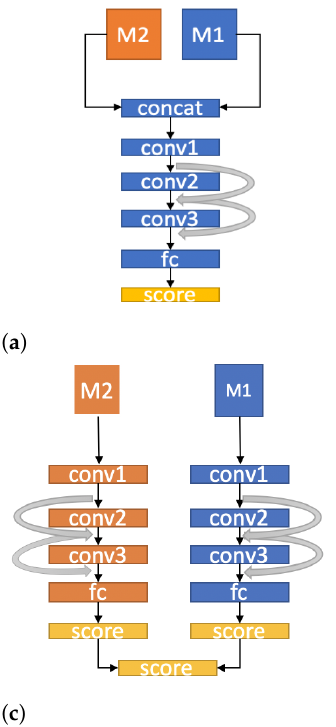
Figure 7. An example of ( a ) early, ( b ) slow, and ( c ) late fusion in HAR. Note that the input modalities are not limited in the above two